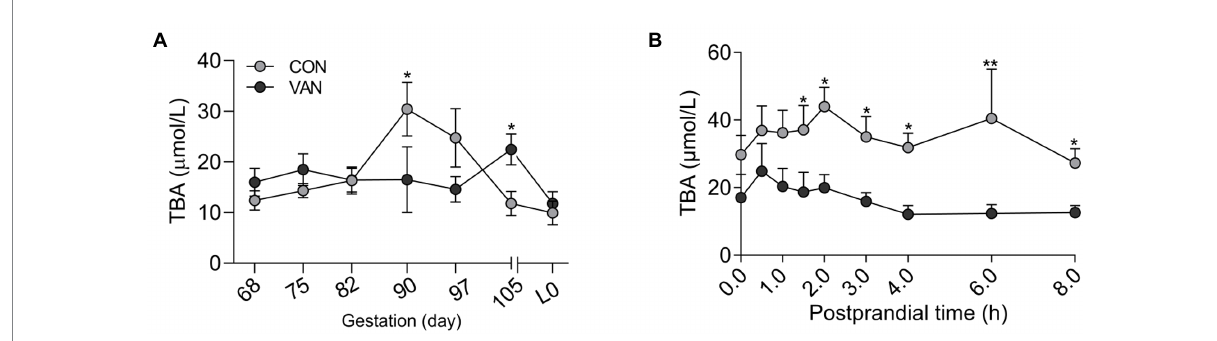
FIGURE 1 (A) The levels of total bile acids (TBA) in maternal peripheral serum after oral VAN from G68 till the farrowing. (B) Dynamic changes of maternal peripheral serum TBA within 8-h postprandial at G90 in the CON and VAN groups. Data are shown as means ± SE, * p < 0.05, ** p < 0.01.